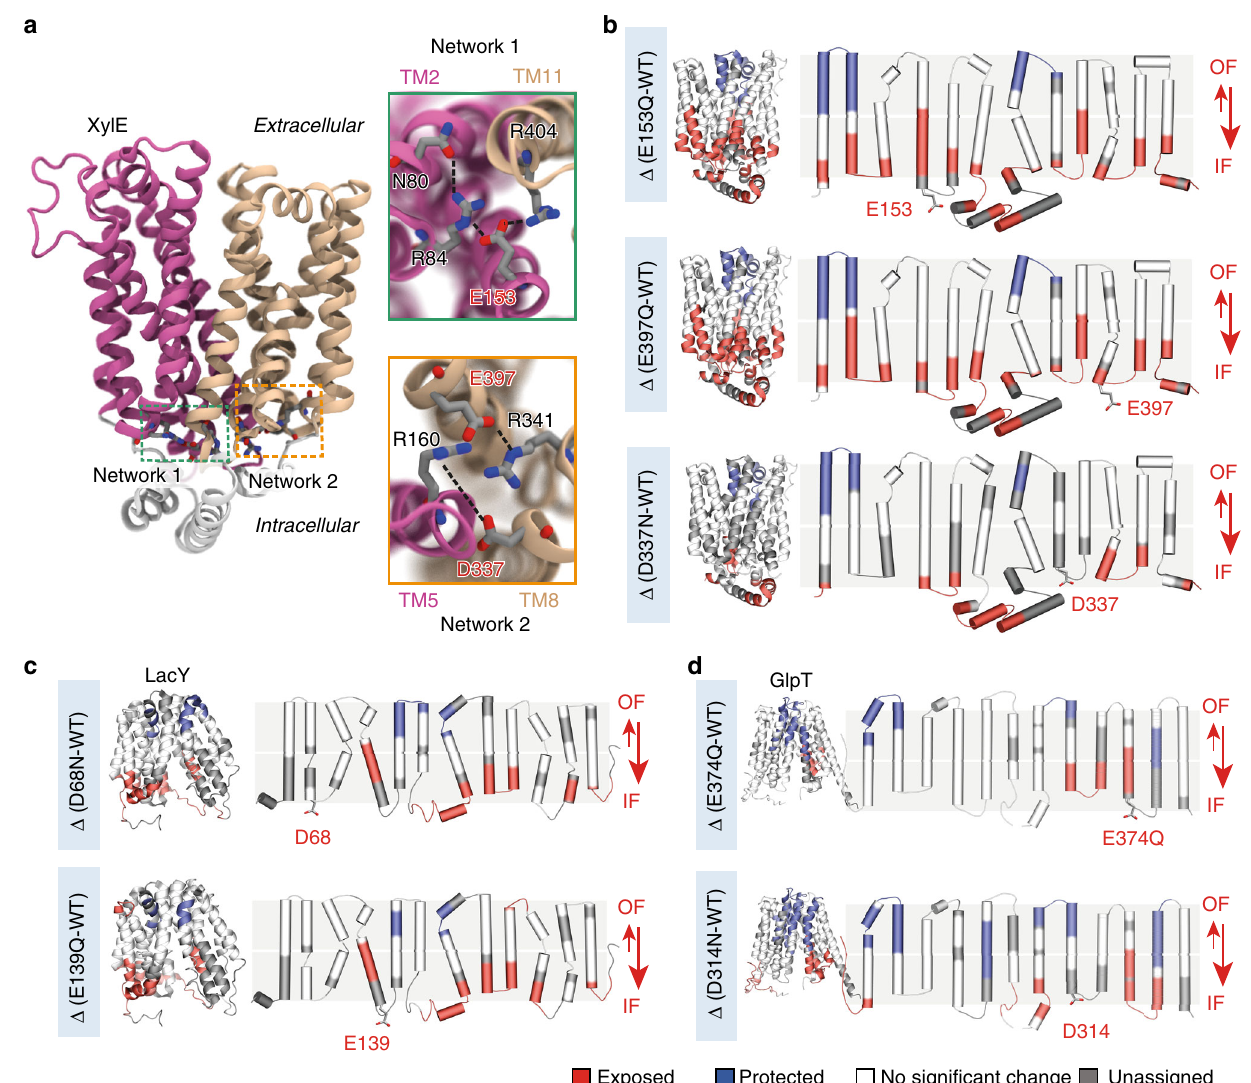
Fig. 2 Conserved charge-relay networks control intracellular opening. Disruption of the networks by conservative mutations (D to N and E to Q) shifts the conformational equilibrium toward the IF state. a Two charge-relay networks of conserved residues stabilize the OF state of XylE. The N- and C-lobes are colored pink and tan, respectively. Close-up of networks 1 and 2 — highlighted in green and orange, respectively — show the connection between the two lobes and highlight in red the mutated acidic residues. b Δ HDX between the mutants E153Q, E397Q, and D337N vs. WT mapped onto the 3D and topological structure of XylE. c Δ HDX of the mutants D68N, and E139Q vs. WT mapped onto the 3D and topological structure of LacY. d Δ HDX of the mutants E374Q and D314N mapped onto the 3D and topological structure of GlpT. All measurements were performed in triplicates on two biological replicates. The Δ HDX datasets are presented as Woods plots in supplementary Figs. 12 and